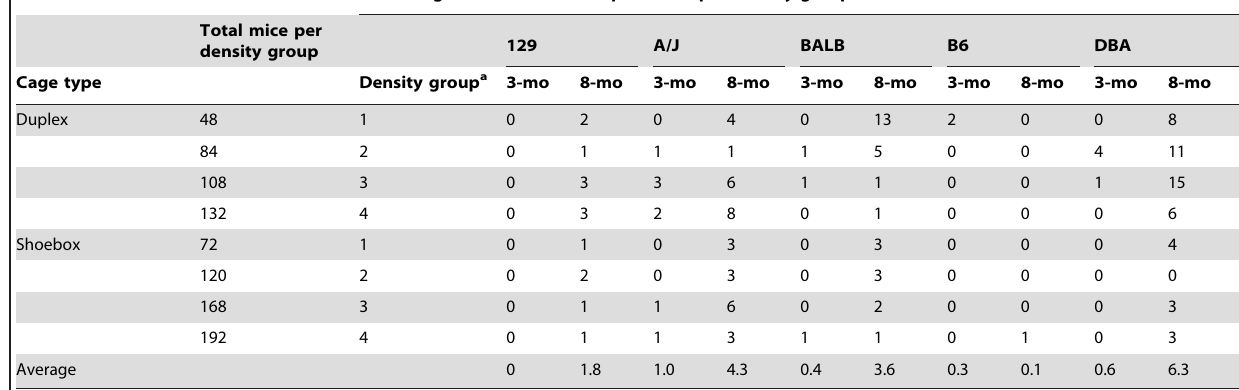
Percentage of mice that died per strain per density